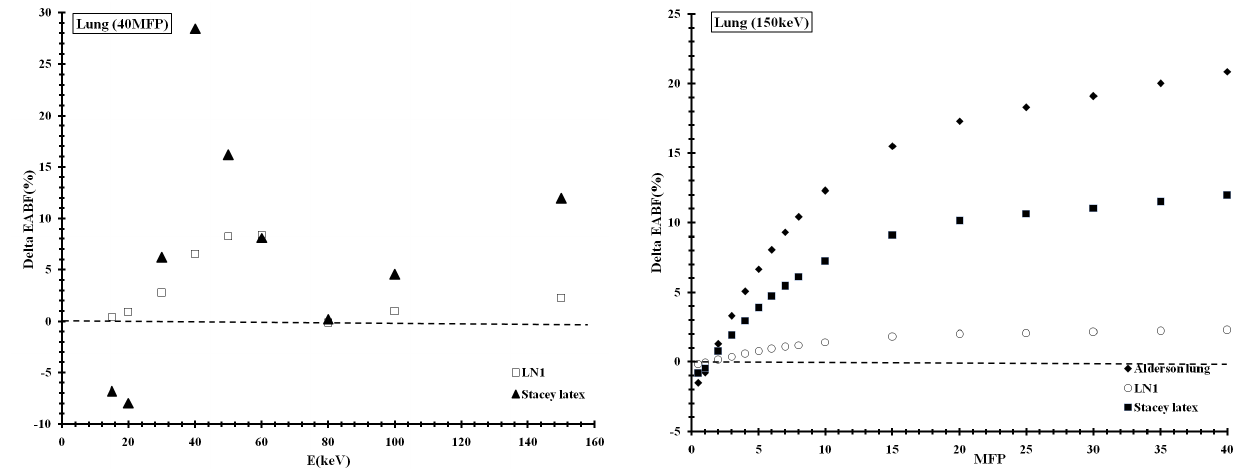
Figure 9. Relative deviation of energy absorption buildup factor of substitute materials to lung tissue as a function of: ( left side) photon energy for fixed depths of 0.5, 15 and 40 mfp and ( right side) depth for fixed photon energy of 30, 80 and 150 keV.